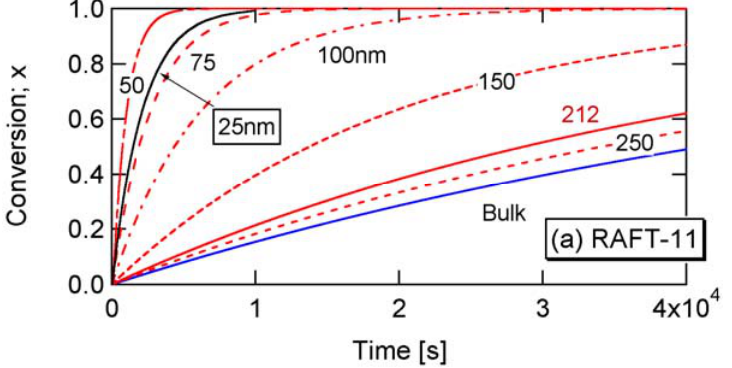
Figure 8. Conversion development of ( a ) RAFT-11, ( b ) RAFT-12, and ( c )